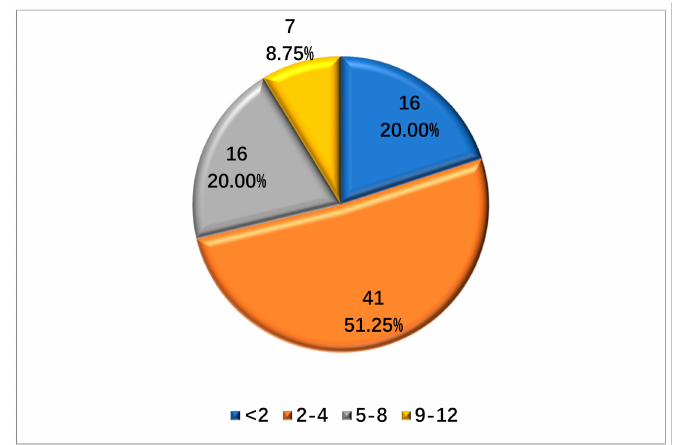
Figure 2. Lund–Kennedy score of study